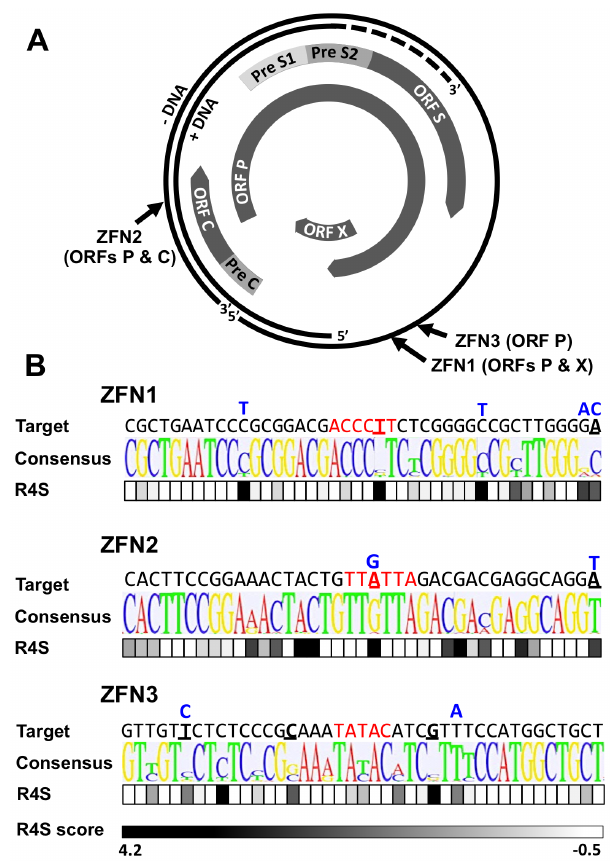
Figure 1. HBV-ZFN target sites. ( a ) HBV rcDNA genome map showing HBV ORFs and ZFN target site locations. ( b ) HBV target site sequence heterogeneity for HBV-ZFN pairs 1–3 across 3847 complete HBV genotype A–H sequences found in Genbank. For each ZFN pair, the target sequence, consensus sequence logo plot and nucleotide Rate4Site (R4S) scores are shown. ZFN spacer nucleotides are highlighted in red and divergent nucleotides between the ZFN target site and the consensus sequence are bold and underlined. Rate4Site scores are graded from low (white) to high (black) sequence heterogeneity. Single nucleotide polymorphisms present in the HepAD38 genomic HBV sequence are shown above each target site in blue. ORF – open reading frame; R4S – Rate4Site; ZFN – zinc finger nuclease.